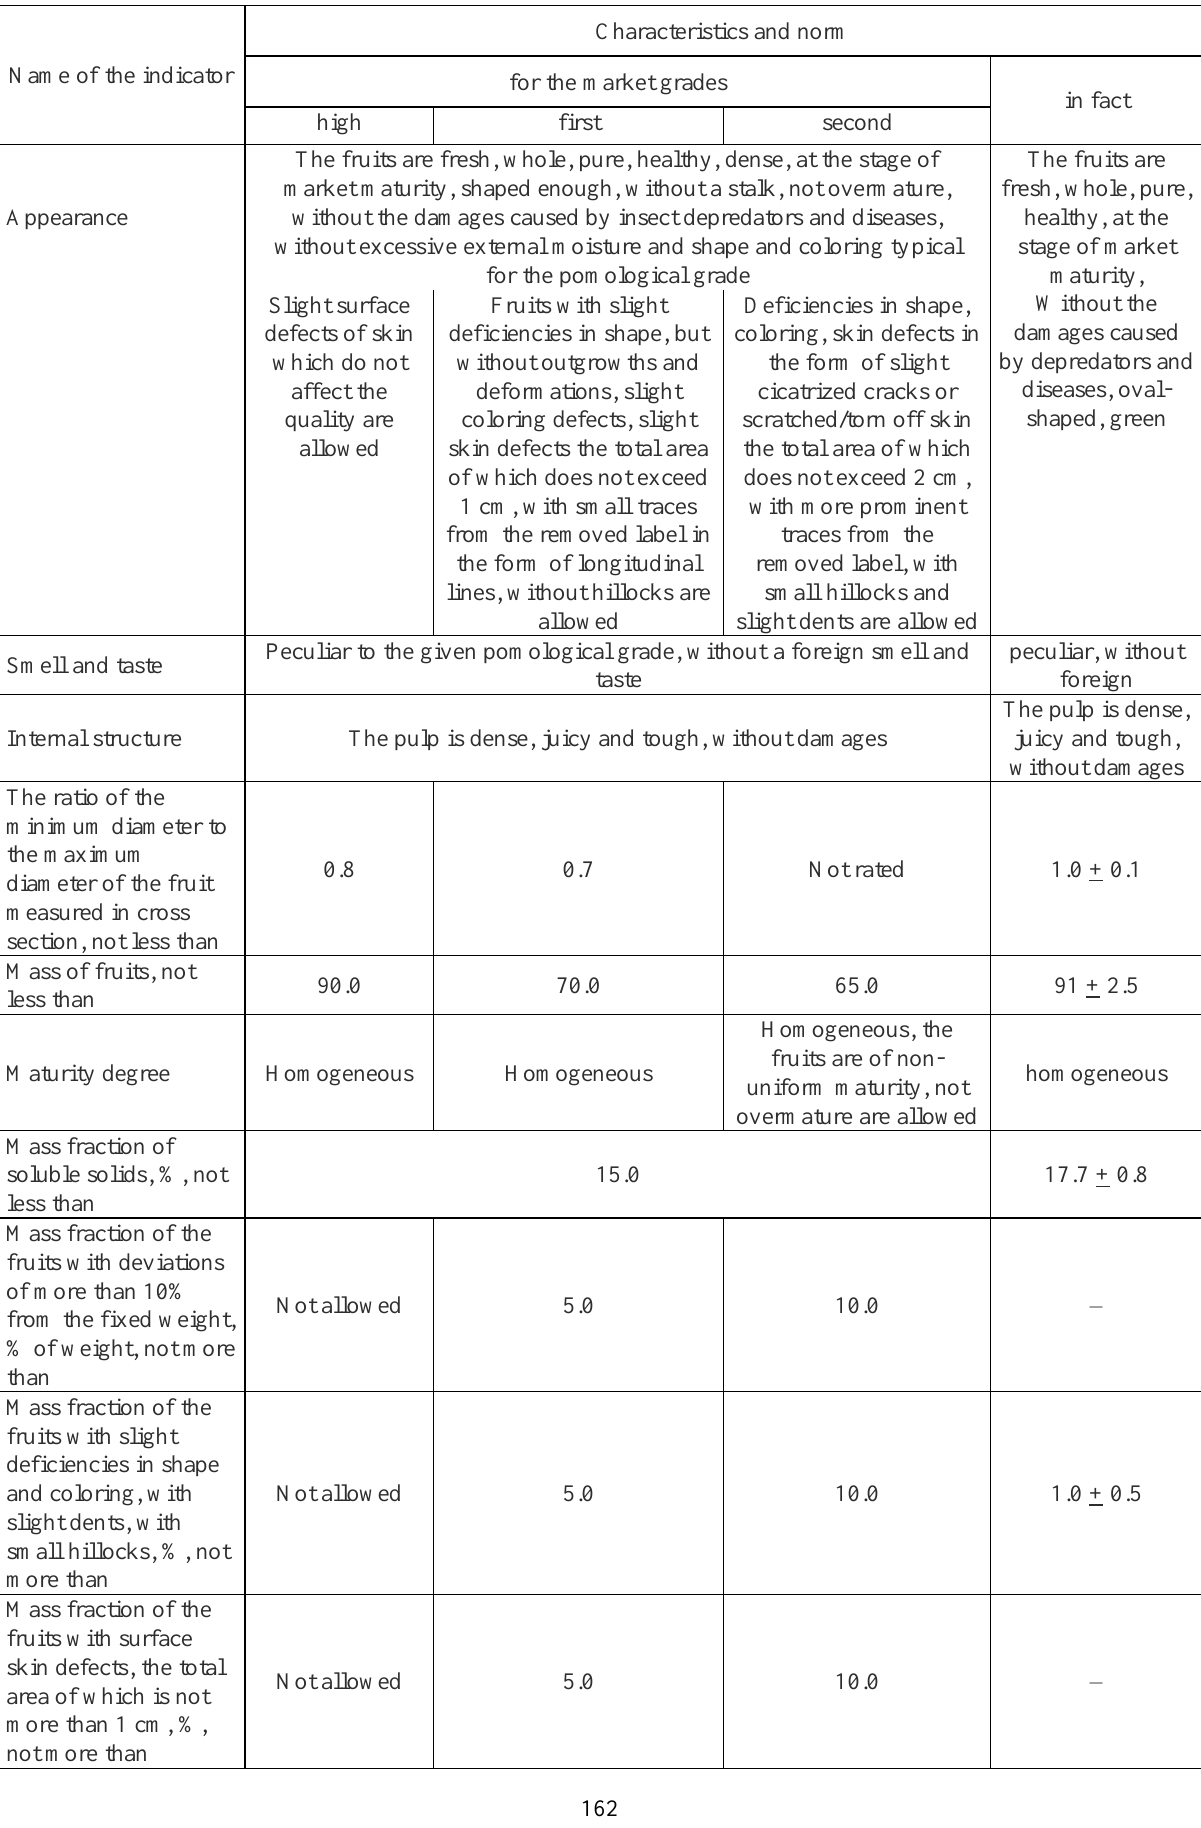
Table 11. Beginning. Indicators of quality of fruits of Actinidia deliciosa (kiwi delicious), n = 5